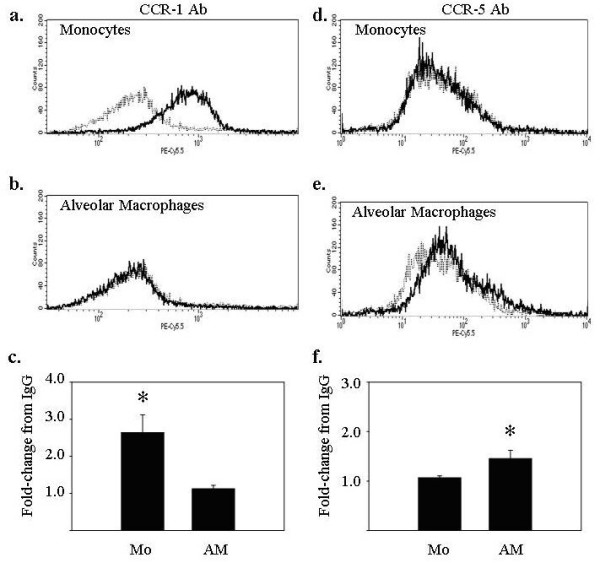
Peripheral blood monocytes and alveolar macrophages differentially express the CCL3 receptors CCR1 and CCR5. Freshly isolated monocytes and alveolar macrophages (5 × 105/condition) were assayed for surface expression of CCR1 (left panels) and CCR5 (right panels) using flow cytometry. (a) Monocytes expressed CCR1 but (d) not CCR5. For monocytes, the average fold-increase in median fluorescence over IgG when staining for (c) CCR1 was 2.37 ± 0.53 (*p < 0.05 versus IgG controls), and when staining for (f) CCR5 was 1.07 ± 0.04 (p > 0.05 versus IgG controls). Alveolar macrophages expressed (d) CCR5, but not (b) CCR1. For alveolar macrophages, the average fold-increase in mean fluorescence over IgG when staining for (c) CCR1 was 1.04 ± 0.04 (p > 0.05 versus IgG controls), and when staining for (f) CCR5 was 1.45 ± 0.17 (*p < 0.05 versus IgG controls). IgG isotype controls are shown (dashed lines). Data are representative of three independent experiments and graphs represent mean ± SEM.